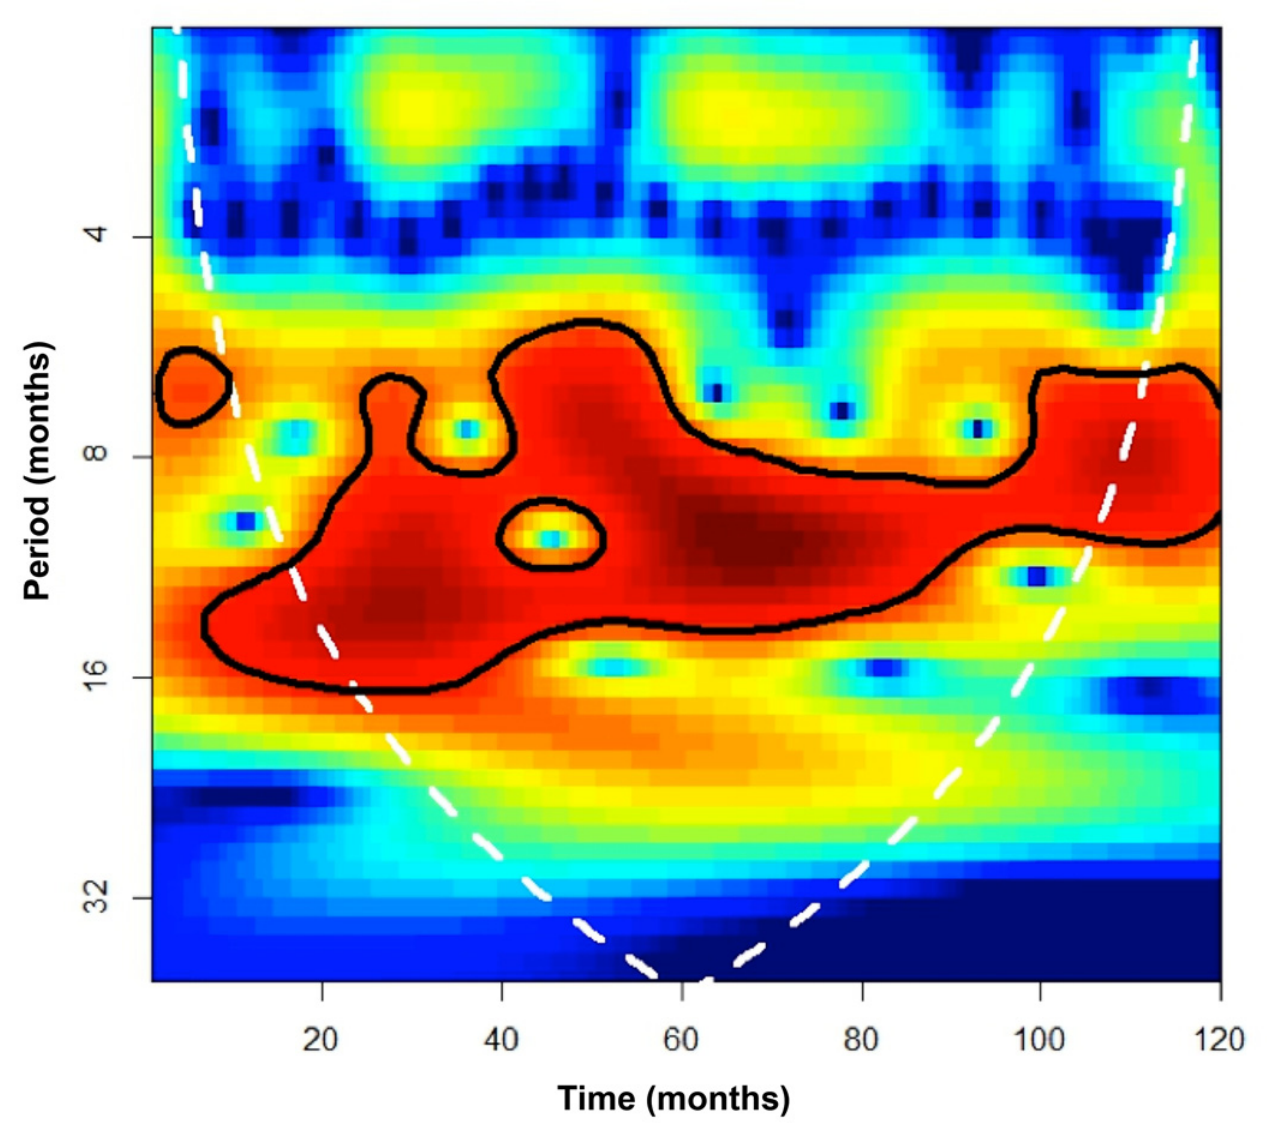
Fig 3. Power spectrum obtained from a continuous wavelet transform based on a Morlet wavelet filter for the detrended and denoised time series of nontuberculous mycobacterial lymphadenitis and skin and soft tissue infection cases combined. The graph shows the power for each period or cycle (y-axis) along the time series (x-axis). High values are shown in dark-red and low values in dark-blue. The dark line contains the statistically significant periods (p < 0.05); the white line is the cone of influence that delimits the area not influenced by